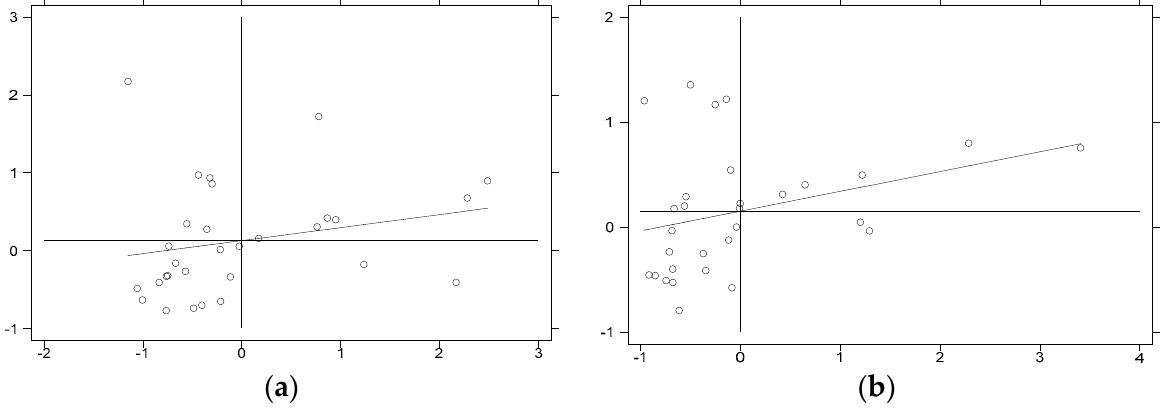
Figure 5. Local Moran’s I scatter diagram of the transfer of high energy-consuming industries. ( a ) Year of 2003. ( b ) Year of 2016. Note: The top left corner of the image is the first quadrant, then counterclockwise in order, the second, third and fourth quadrants.